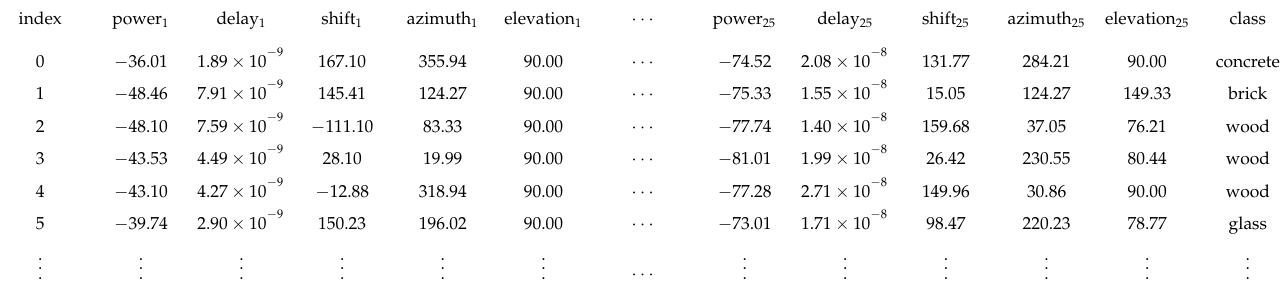
Figure 5. Excerpt from